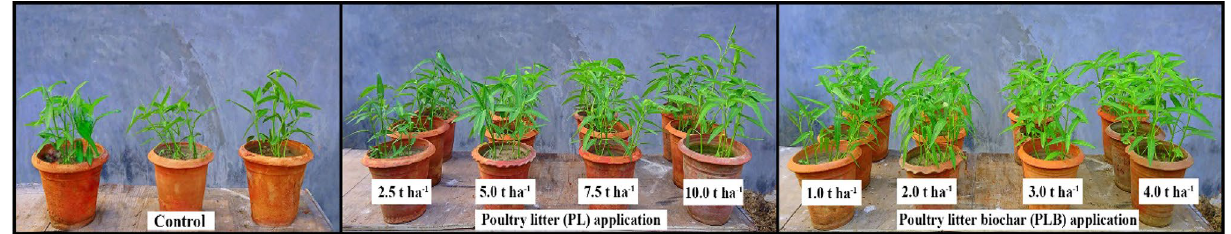
Fig. 1 Growth performance of gima kalmi treated with PL and